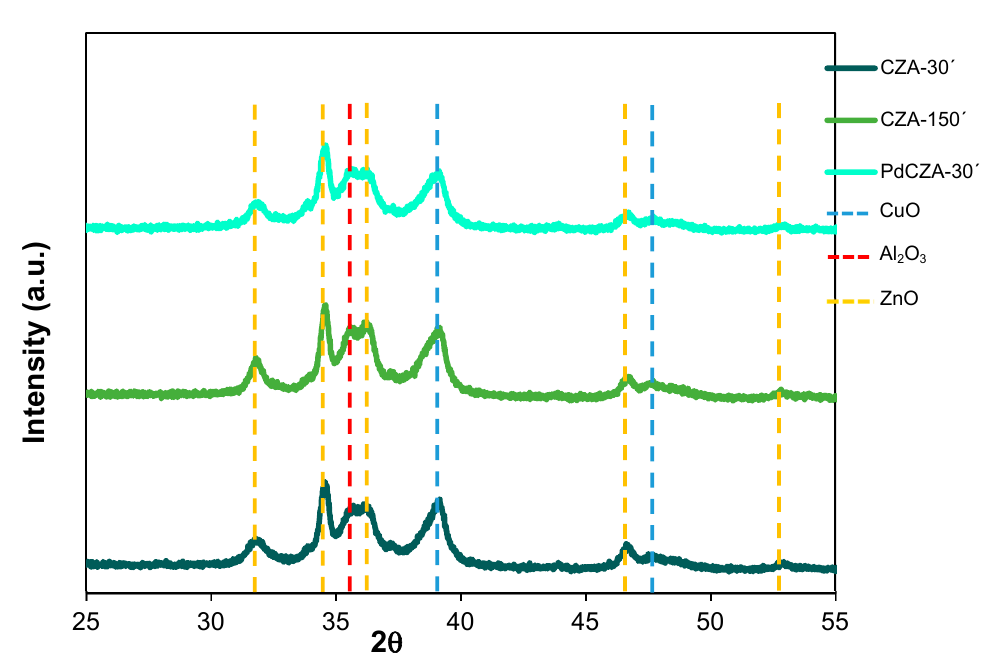
Figure 2. XRD diffractogram for CZA-30 ′ , CZA-150 ′ , and PdCZA-30 ′ .